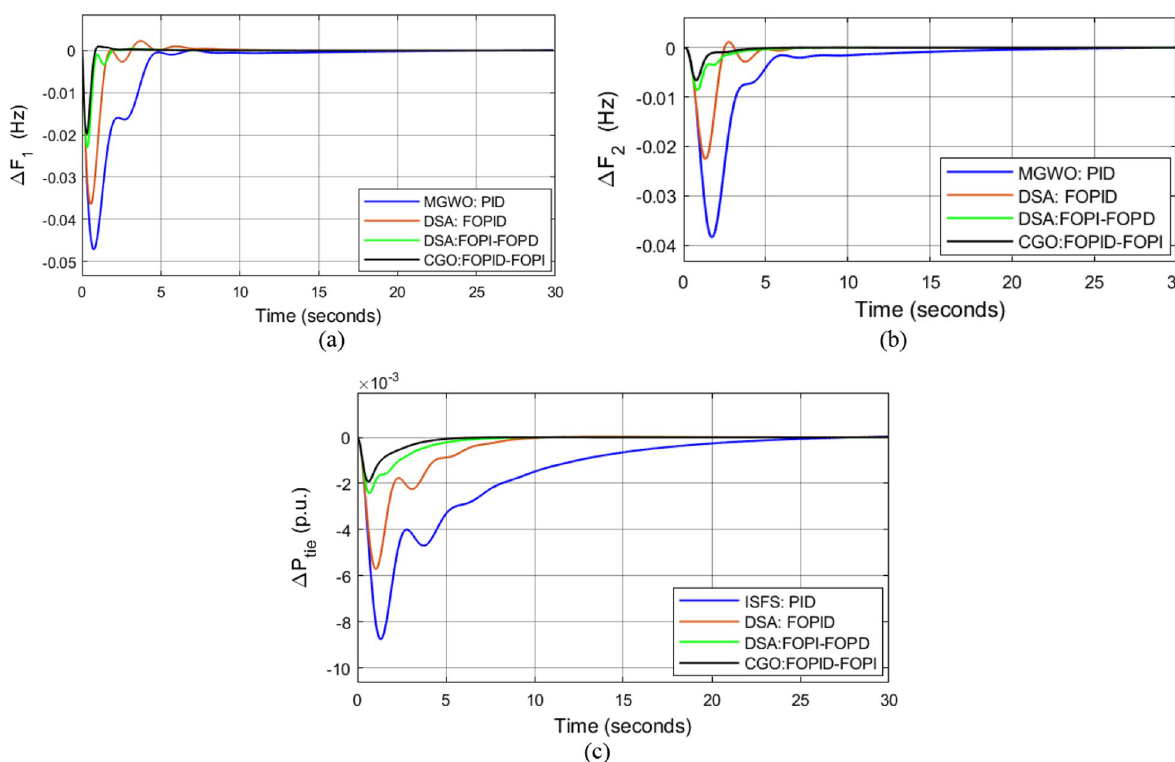
Fig. 13 Comparison of dynamic responses for Test-system 3 under 2% SLP in area 1: a ΔF1, b ΔF2, and c